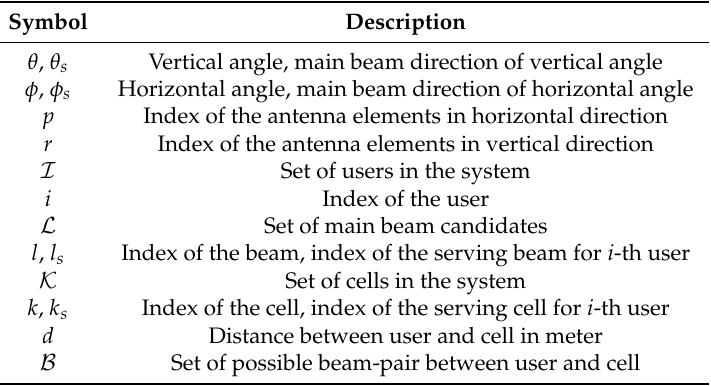
Table 1. Description of